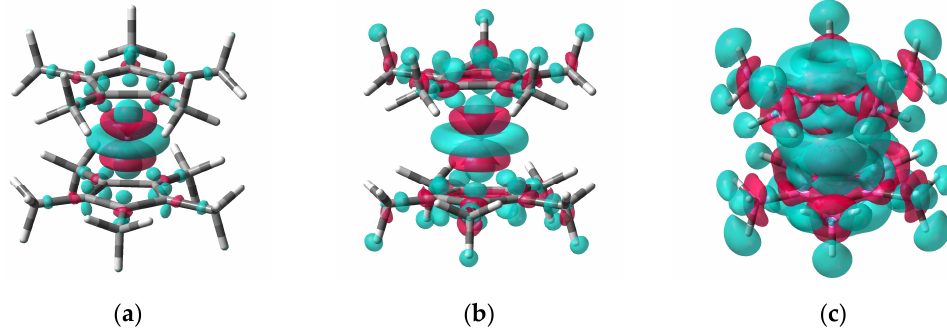
Figure 7. Isosurfaces of the electron density difference between the Cp* 2 Mn + cation and neutral Cp* 2 Mn 0 at the optimized geometry of the latter (vertical ionization of Cp* 2 Mn). The isovalues are 0.005 a.u. ( a ), 0.003 a.u. ( b ) and 0.001 a.u. ( c ). The blue and red colors correspond to the loss and gain of ED, respectively.